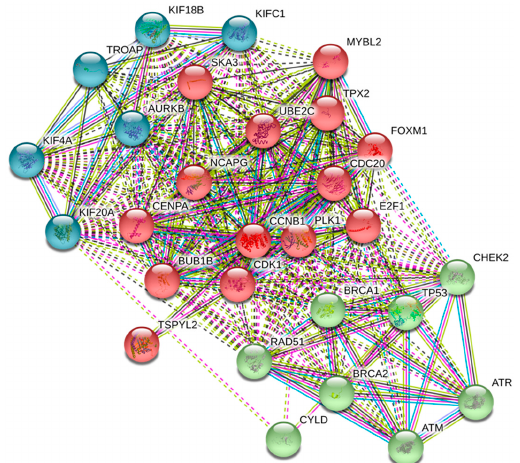
Figure 5. UBE2C protein network. Proteins with a strong to very strong positive correlation with UBE2C in most of the 27 cancers and some tumor suppressors are clustered in three categories based on the kmeans clustering option in STRING. In the cluster indicated in blue, different members of kinesin Family (KIF20A, KIF18B, KIFC1, and KIF4A) are included, which function as microtubule-dependent molecular motor, AURKB (a serine/threonine-protein kinase component of the chromosomal passenger complex, CPC) with an essential role in the regulation of mitosis, and TROAP involved in cell adhesion molecule complex. Another cluster shown in red (TPX2, UBE2C, PLK1, CDK1, CENPA, CDC20, MYBL2, BUB1B, CCNB1, NCAPG, SKA3, E2F1, FOXM1, and TSPYL2) is involved in different vital cellular processes, such as cell cycle, regulation of cellular metabolic process, cellular protein modification, signaling, chromosome organization, histone modification, and others as described in Table S2 file. The last cluster in green includes major tumor suppressor genes, including BRCA2, BRCA1, CHEK2, ATR, ATM, TP53, RAD51, and CYLD. Table 4. Biological pathways related to proteins involved in UBE2C network.